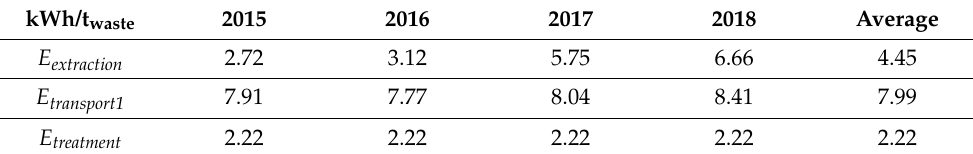
Table 7. Extraction, transport 1, and treatment energies (kWh/t waste ). kWh/t